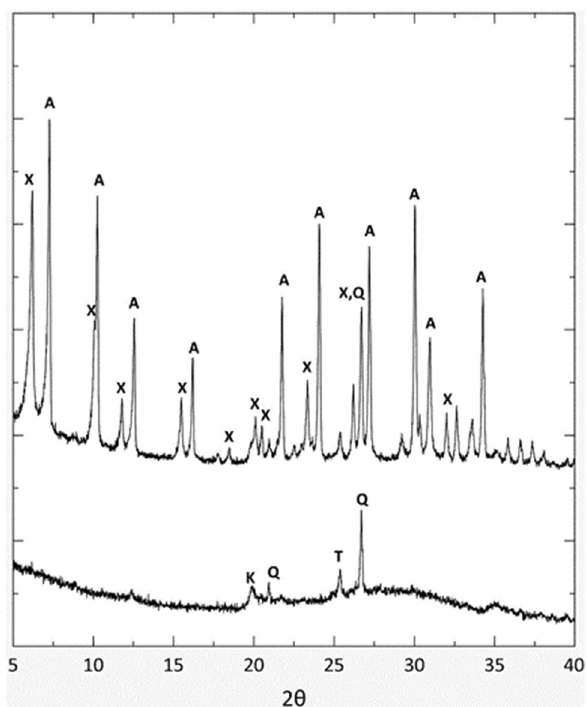
Figure 2. XRD pattern for one day (bottom) and three days (top) of curing. A zeolite LTA, X zeolite X, Q quartz, K feldspar, T titanium